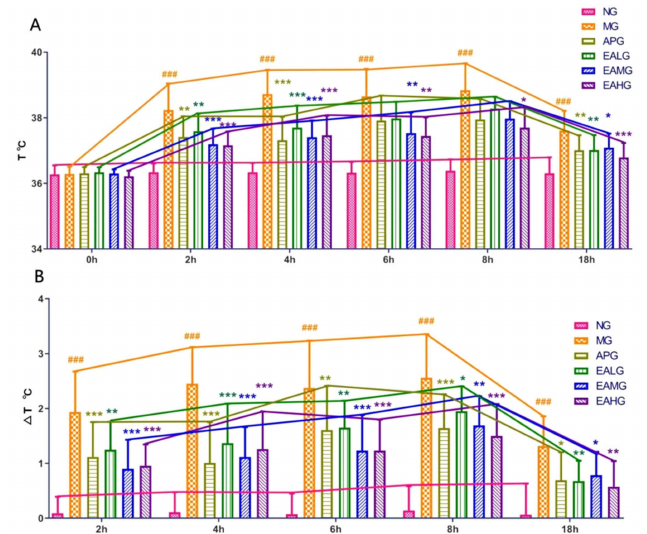
Figure 2. Antipyretic effects of Aspirin and EA. ( A ): The temperatures were measured at 0, 2, 4, 6, 8 and 18 h after yeast administration ( n = 8). ( B ): Temperatures change value at 2, 4, 6, 8 and 18 h after yeast administration ( n = 8). p value is for individual time point. (### p < 0.001, vs. NG, indicates significantly different results compared with NG; * p < 0.05, ** p < 0.01, *** p < 0.001, vs. MG, indicate significantly different results compared with the model that was incubated with 15 mL/kg